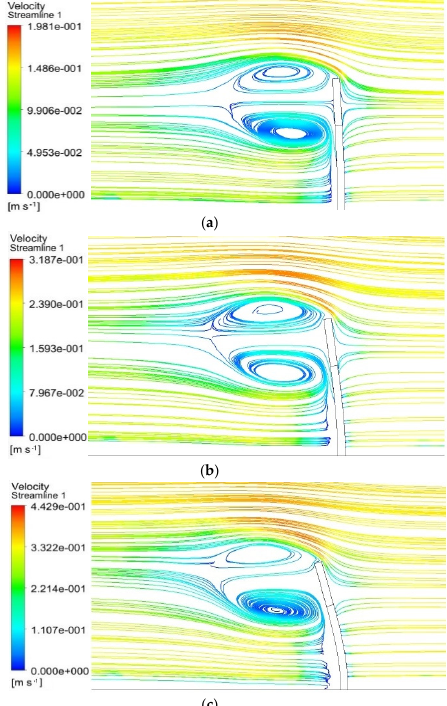
Figure 16. Streamline (m) of T-shaped flexible beam at t = 10 s ( a ) Re = 25,500, ( b ) Re = 42,500, and ( c ) Re =